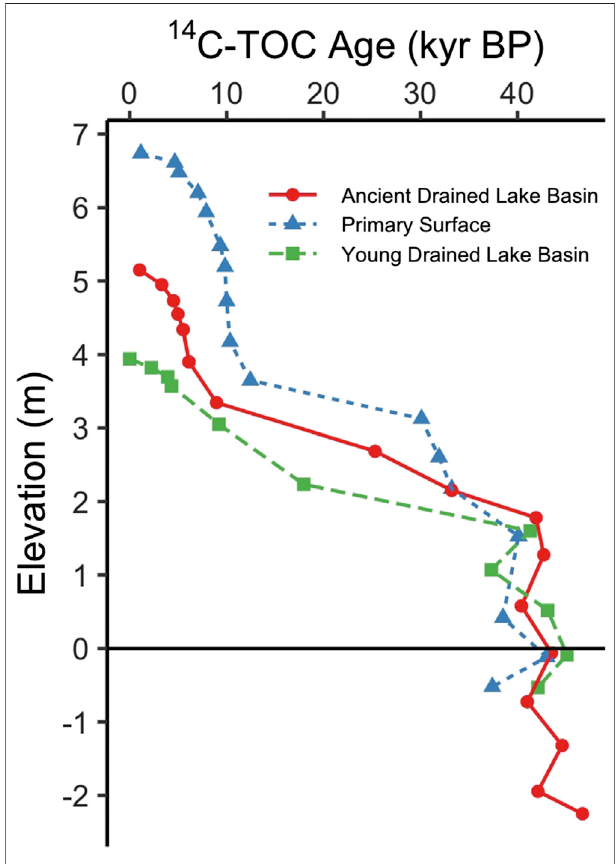
FIGURE 4 | Elevation pro fi les of 14 C-TOC ages sampled from three permafrost cores. Colors and symbols indicate the geomorphic terrain unit each core was sampled from. The black horizontal line indicates local mean sea